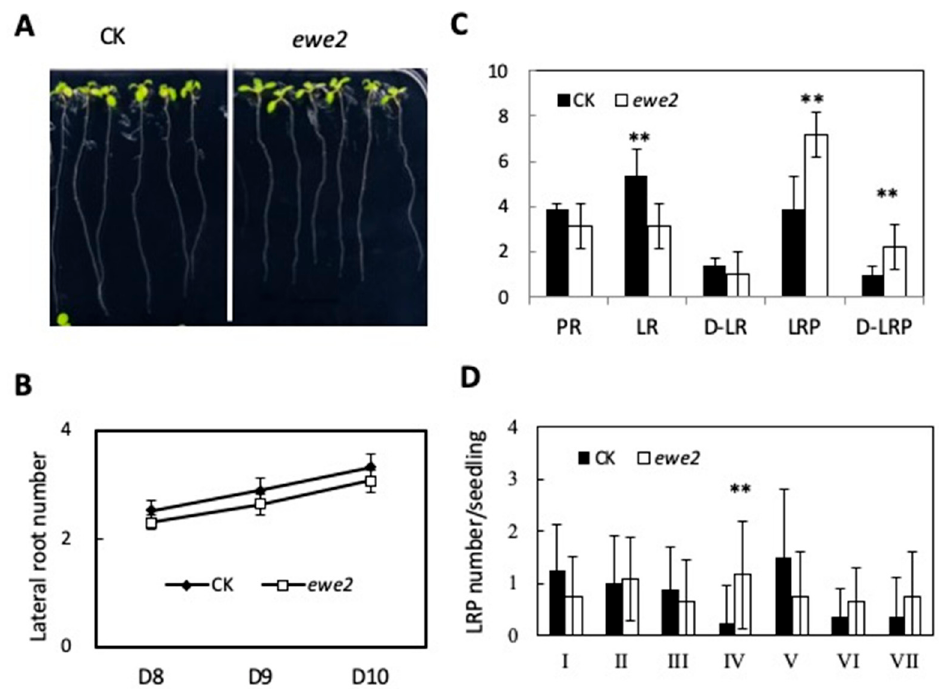
Figure 4. Characterization of the ewe2 mutant. ( A ) ewe2 mutant and wild type seedlings, 12 days after germination. CK, the parent line containing the pWOX7pro::GFP reporter gene in wild type background (Columbia). ( B ) Lateral root (LR) per seedling from day 9–12 after germination. n = 13. ( C ) Primary root length (PR), lateral root numbers (LR), lateral root density (D-LR), lateral root primordia number (LRP), and lateral root primordia density (D-LRP) 14 days after germination. n = 13. ( D ) Number of lateral root primordial per seedling at various developmental stages in 12 day-old seedlings. n = 12. The asterisks indicate degree of significance in the comparison, t -test, two-tailed. * p < 0.05, ** p < 0.01.